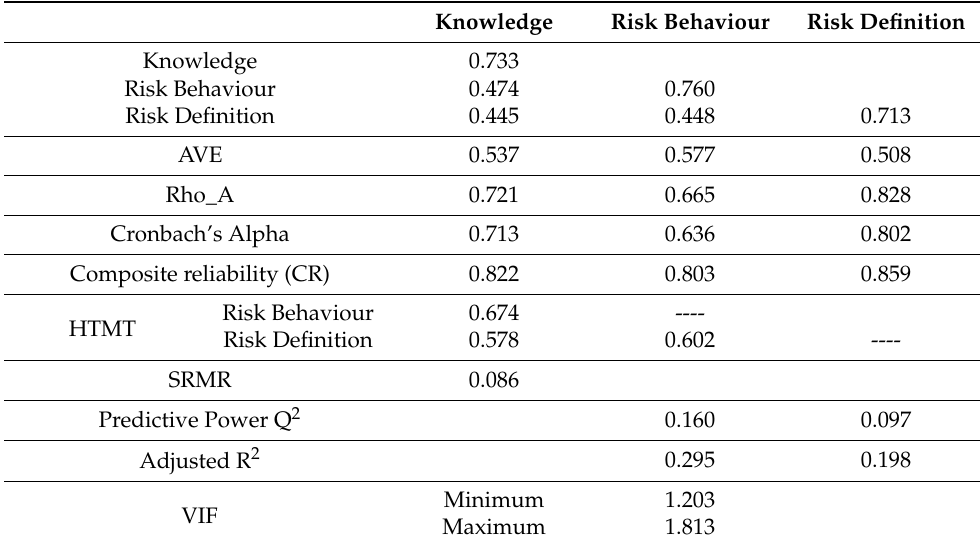
Table 7. Evaluation of Reflective Measurement Models and Structural Models for Model